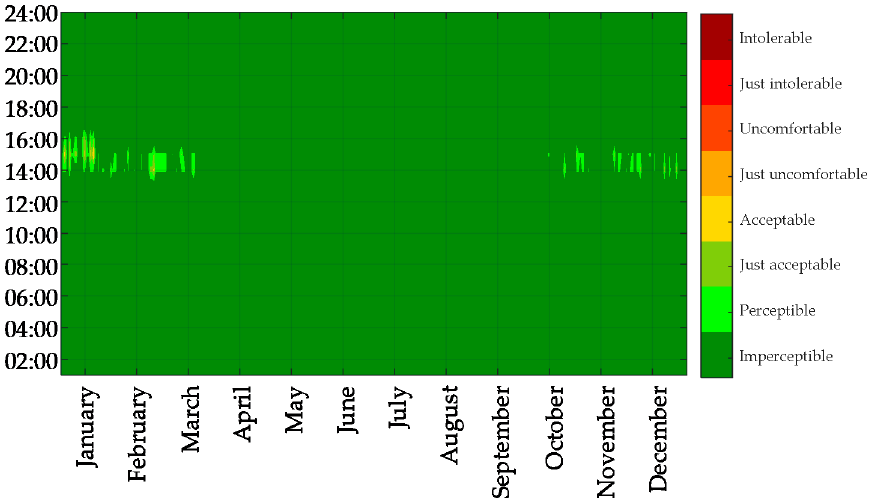
Figure 9. Annual DGI values in an office zone with south orientation in Athens.